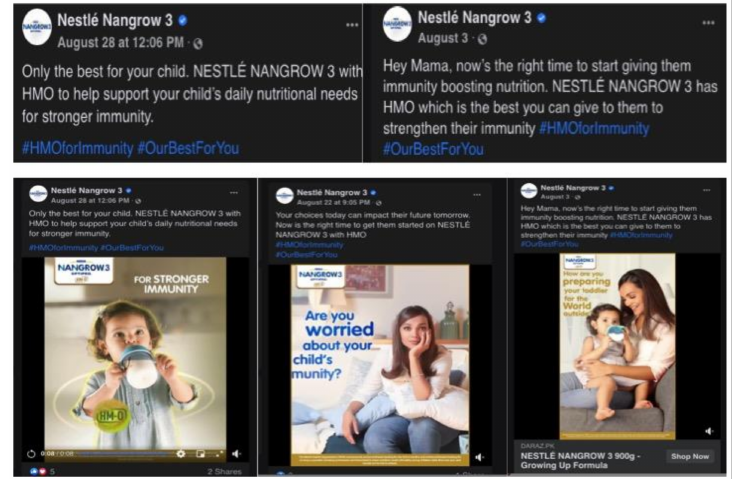
Figure 2. Screenshots of advertisements from Nestl é ’s Nangrow 3 Facebook page in Pakistan, featuring immunity claims and fear-provoking